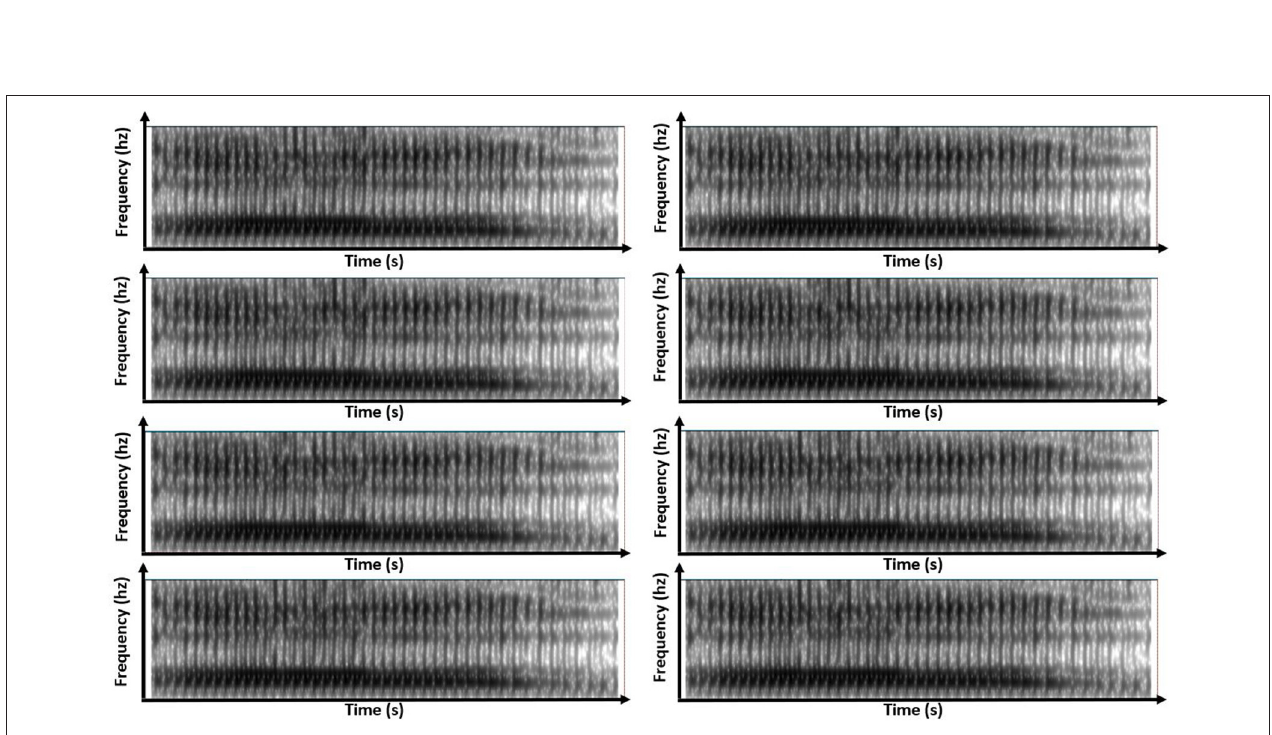
FIGURE 4 | Eight panels of spectrograms for each of the eight variants of simulated-speech contexts simulating the speech context “[al]”.